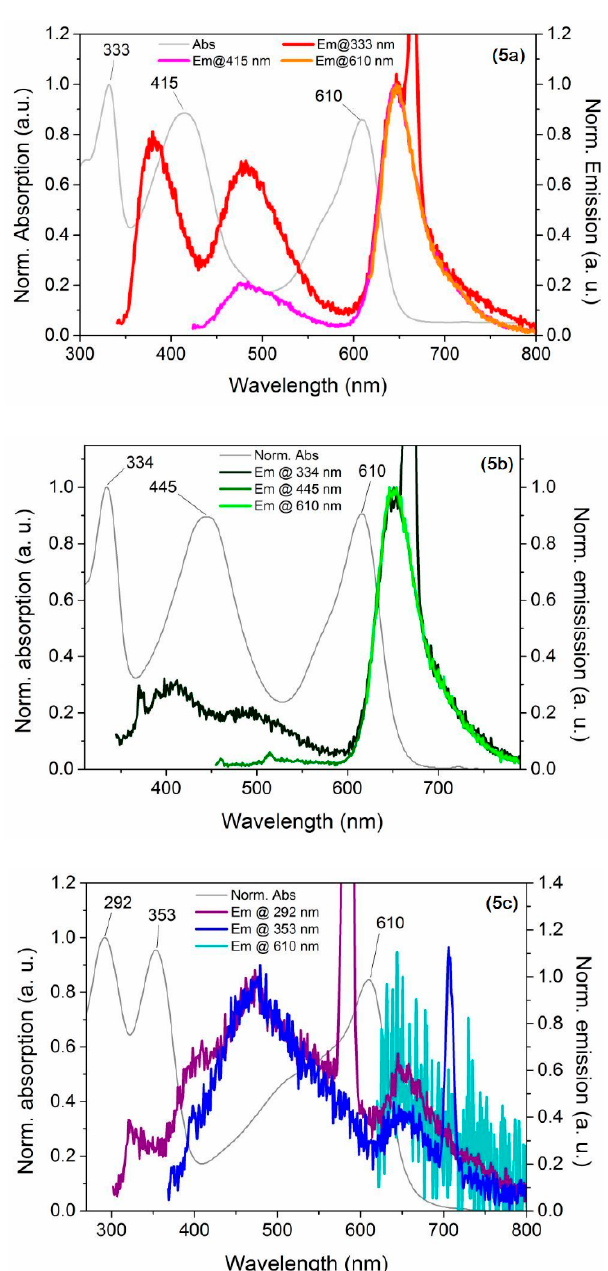
Figure 7. UV − Vis absorption and fluorescence emission spectra of compounds 5a – c in CH 2 Cl 2 solution. ( 5a ): in the emission trace after excitation at 333 nm (red line) the peak visible at 666 nm is due to the second-order diffraction of the incident light. ( 5b ): in the emission trace after excitation at 334 nm (dark green line) the sharp peak visible at 668 nm is due to the second-order diffraction of the incident light. ( 5c ): in the emission traces after excitation at 292 nm (purple line) and 353 nm (blue line), the sharp peaks visible at 584 nm and 706 nm are due to the second-order diffraction of the incident light.